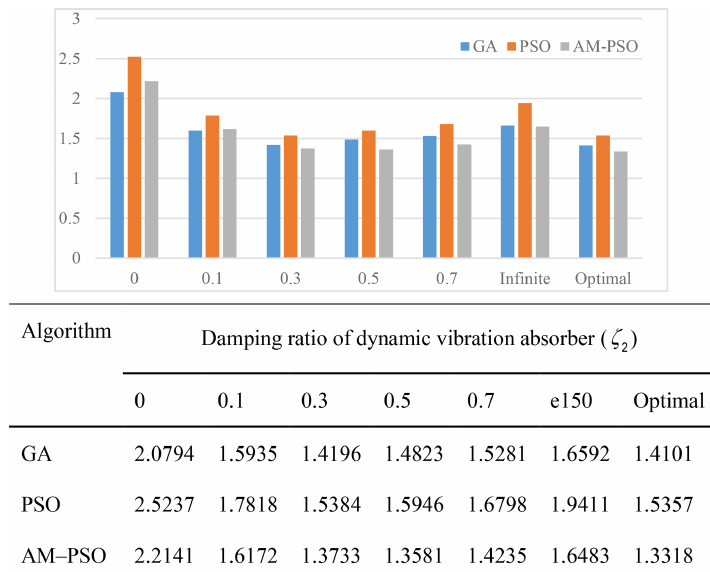
Figure 8. Influence of damping ratio of dynamic vibration absorber on numerical algorithm.